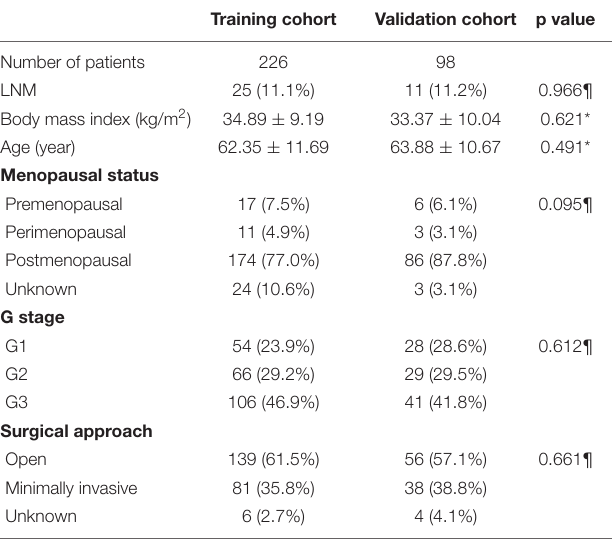
TABLE 1 | Clinical Characteristic of the Training and Validation